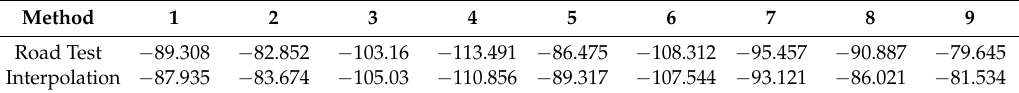
Table 3. Comparison of test results of two methods (unit: